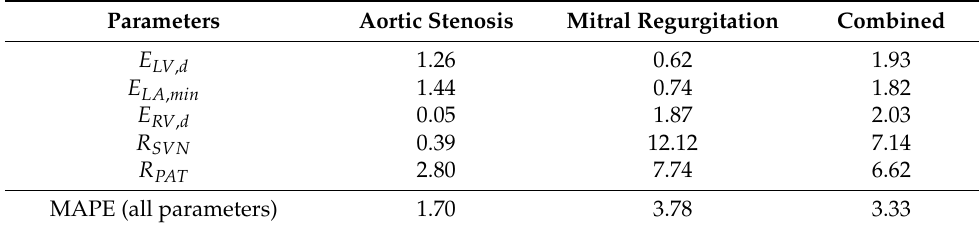
Table 7. Absolute percentage errors (APEs—Equation (30)) per parameter for datasets generated